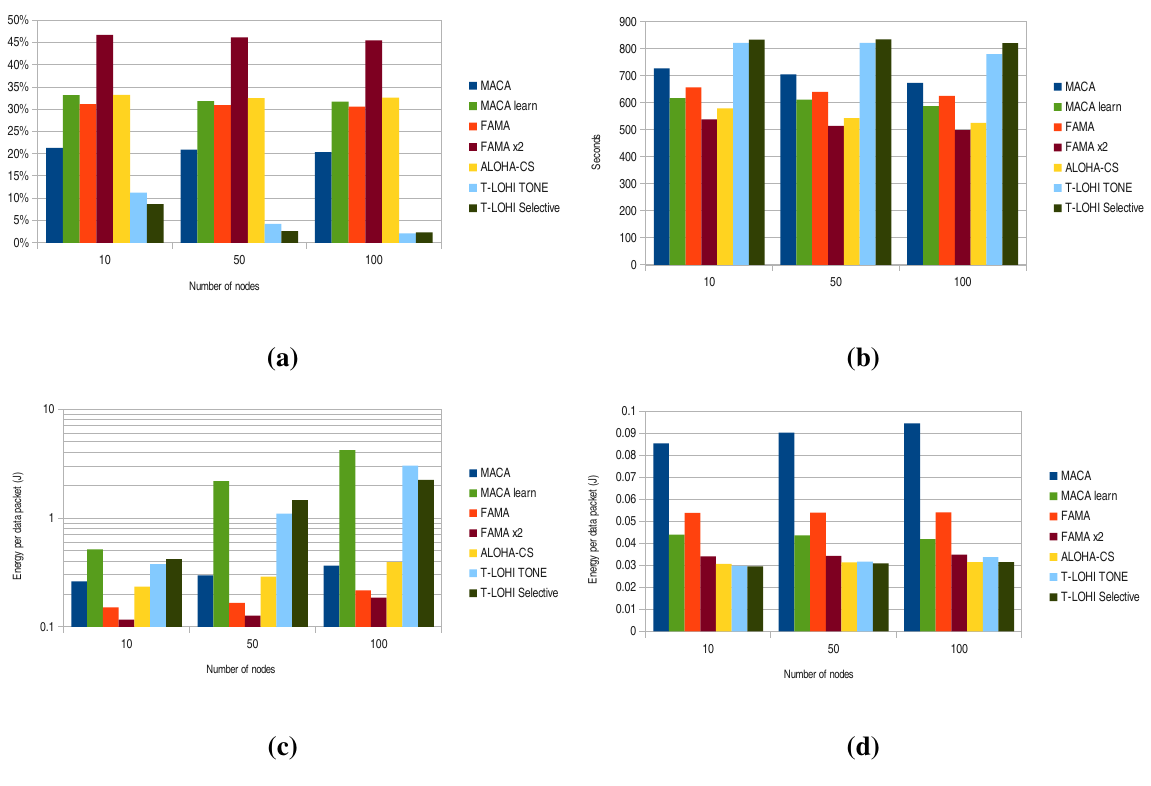
Figure 11. Results without acknowledgment. ( a ) Normalized received packets; ( b ) delay; ( c ) energy per data packet—node; ( d ) energy per data